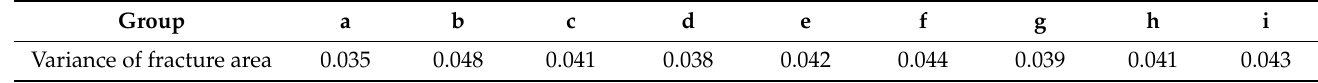
Table 3. Variance of crack area in the parallel test.